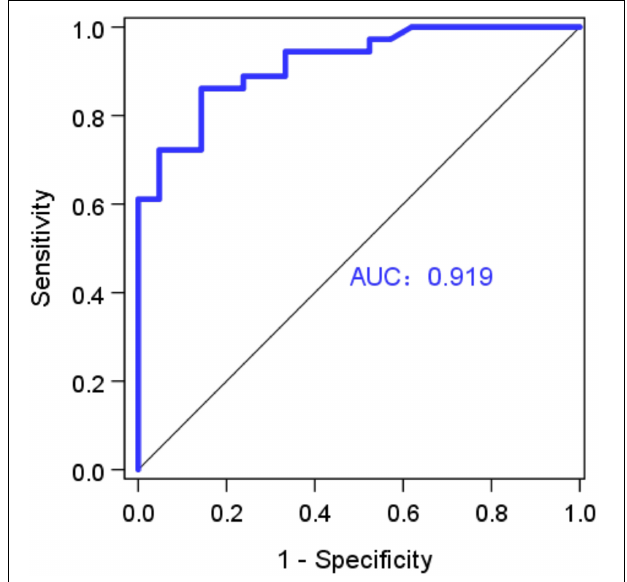
FIGURE 3 | Receiver-operating curve for wire-derived IMR (a cutoff of 25) and caIMR (a cutoff of 25), where AUC (area under the curve) is 0.919 (Vessel Number: n =